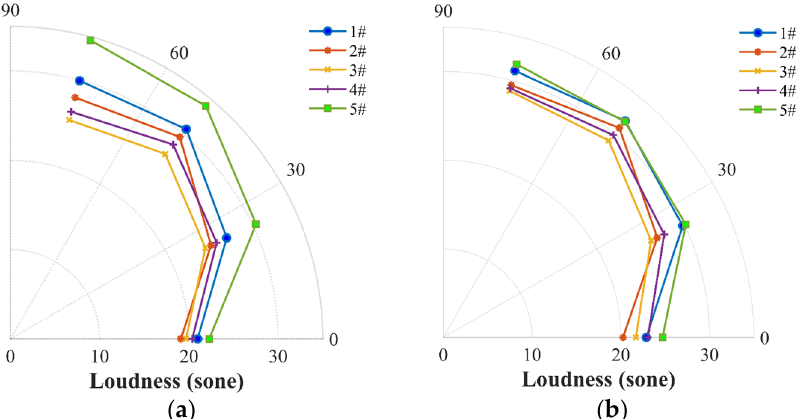
Figure 13. Comparison of noise loudness among the two-blade propeller (#1), four-blade propeller (#2), loop-type propeller (#3), wide chord loop-type propeller (#4), and DJI Phantom III propeller (#5) at a rotational speed of 5400 rpm ( a ) and at a stable thrust of 3 N ( b ).